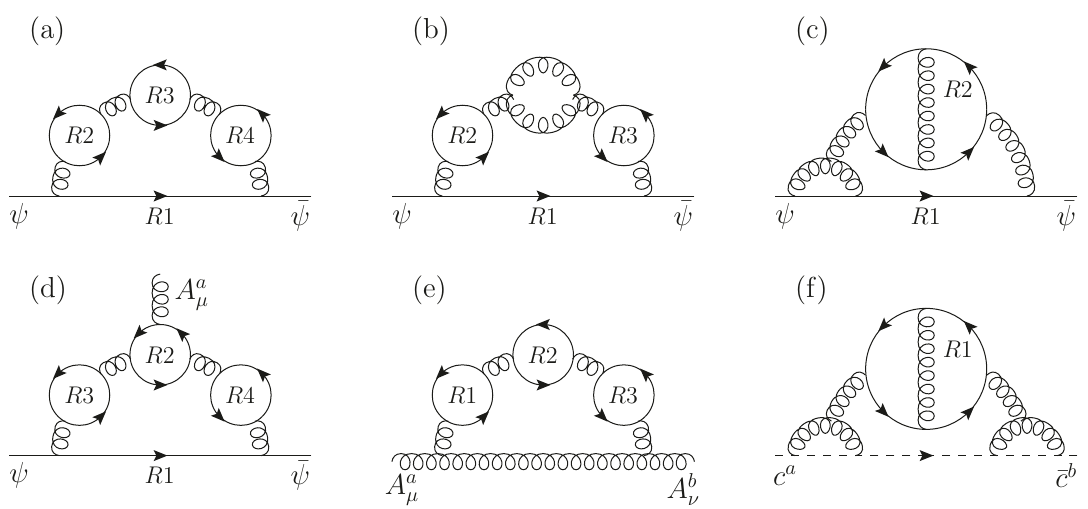
Figure 1 . Four-loop diagrams contributing to the fermion self-energy (a,b,c), the fermion-gauge- boson-vertex (d), the gluon self-energy (e) and the ghost self-energy (f). Each fermion line is initially treated as a di(cid:11)erent representation R 1 ; : : : ; R